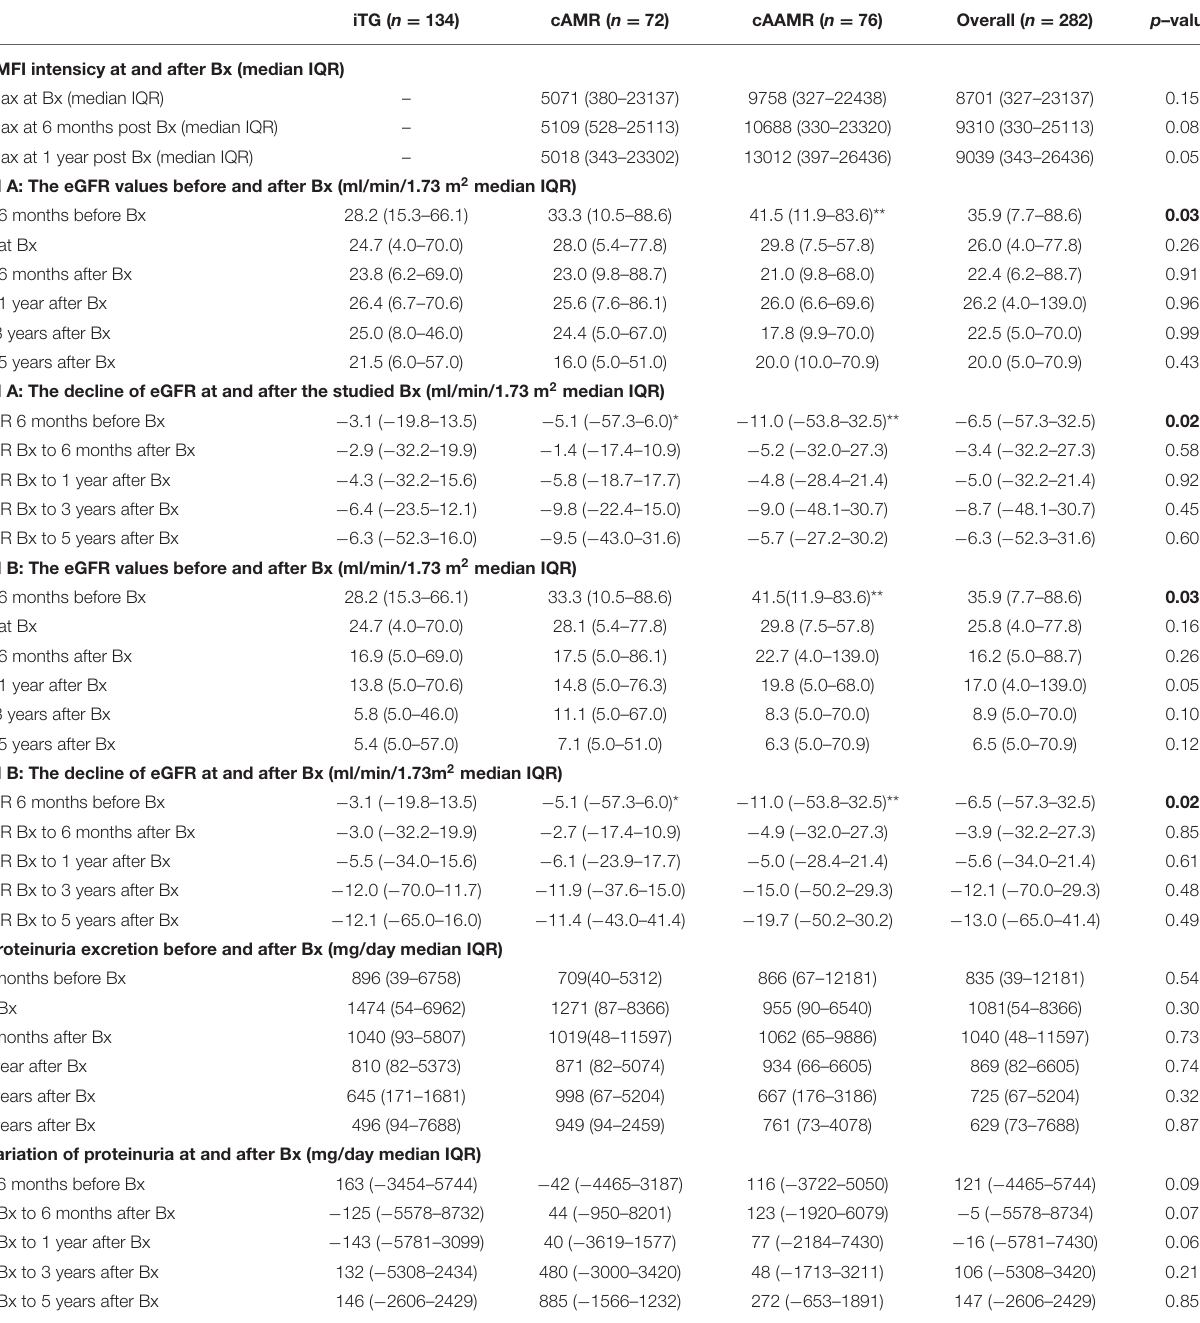
TABLE 3A | Variation of DSA, estimated glomerular filtration rate (eGFR), and daily proteinuria pre-, at-, and post-studied biopsies in relation to TG